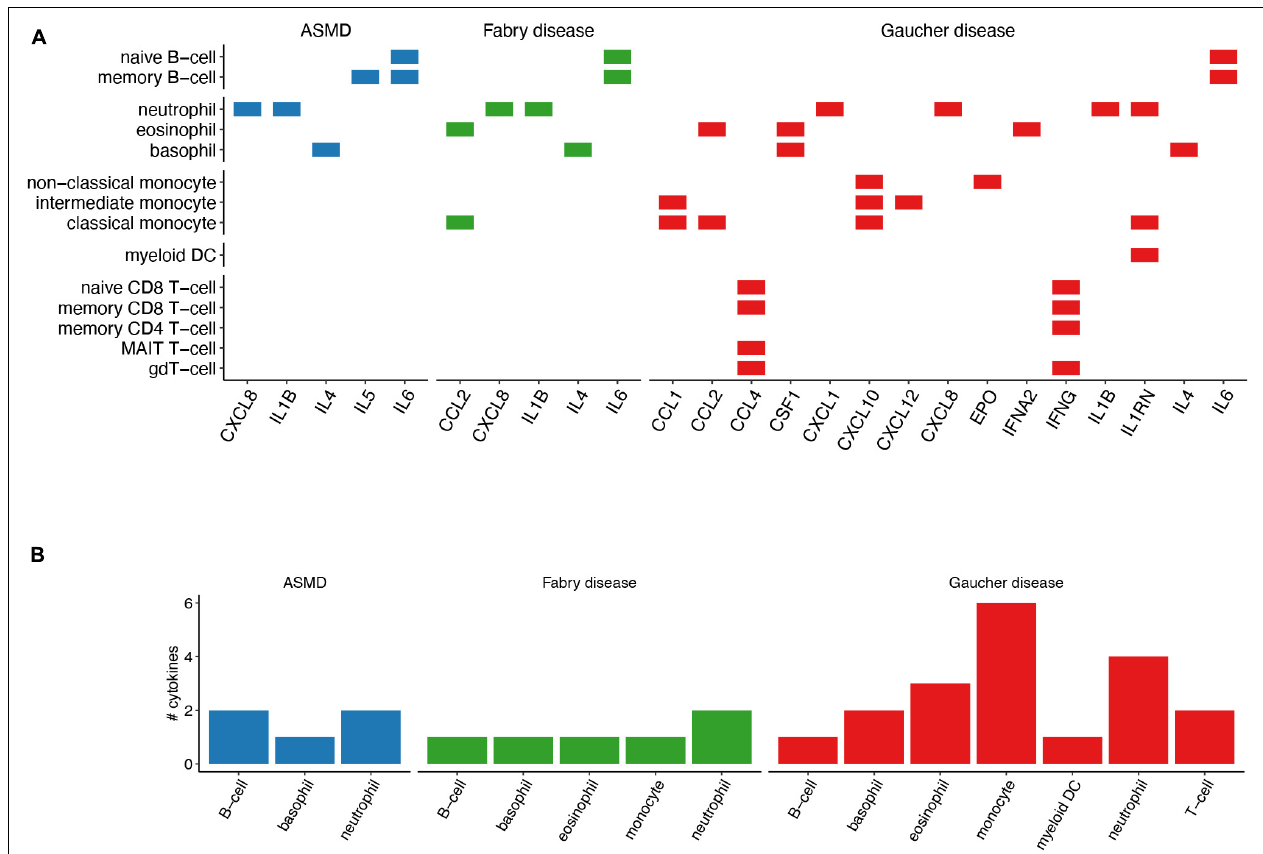
FIGURE 3 | Immune-cell specificity of the identified cytokines. (A) The chart shows the cytokines that are reported as cell-specific (cell-type enriched or group enriched) by the HPA Blood Atlas. (B) Number of cell-specific cytokines per cell-type. Compared with the analysis in panel (A) , B-cells, T-cells and monocytes have been grouped in one cell